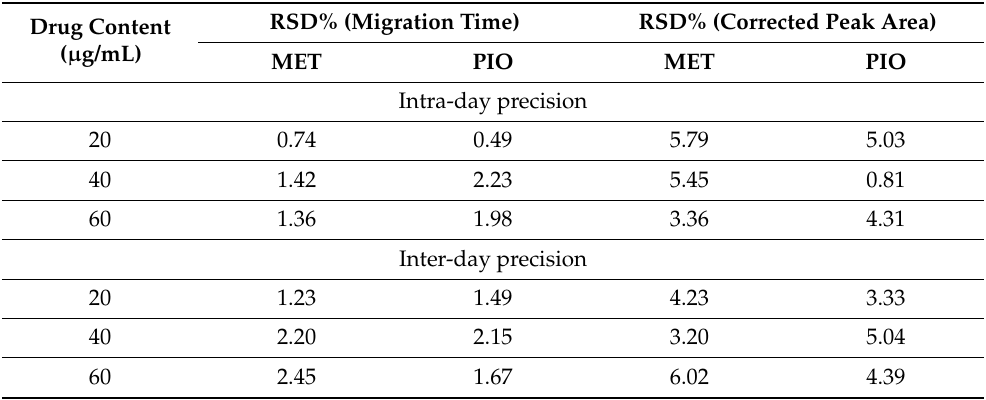
Table 1. Relative standard deviation (RSD) values of repeatability and intermediate precision of the capillary zone electrophoretic assay method for MET and PIO.